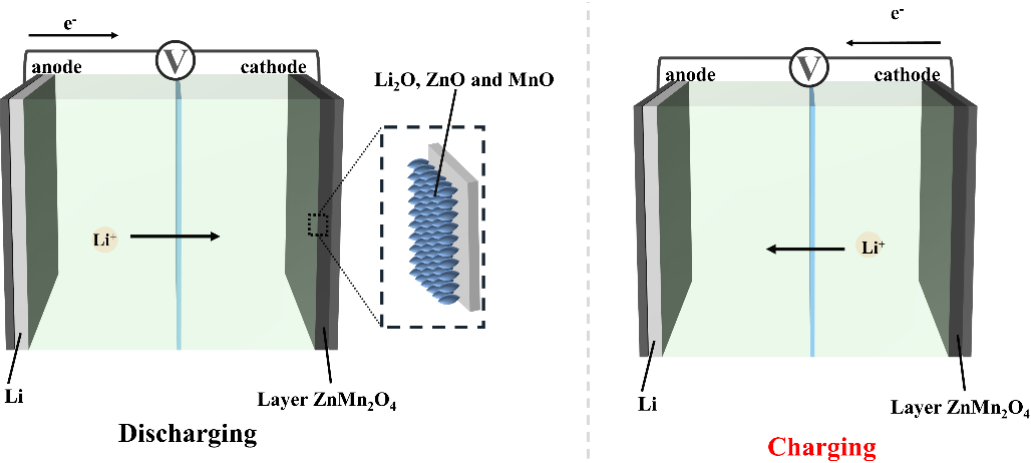
Figure 3. Charge and discharge processes of ZnMn 2 O 4 -Li battery with metallic oxide electrode.